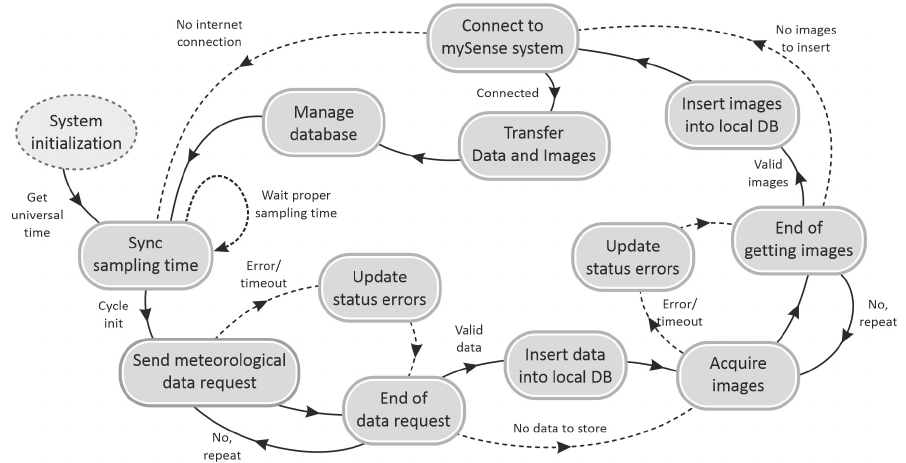
Figure 3. OPi’s software